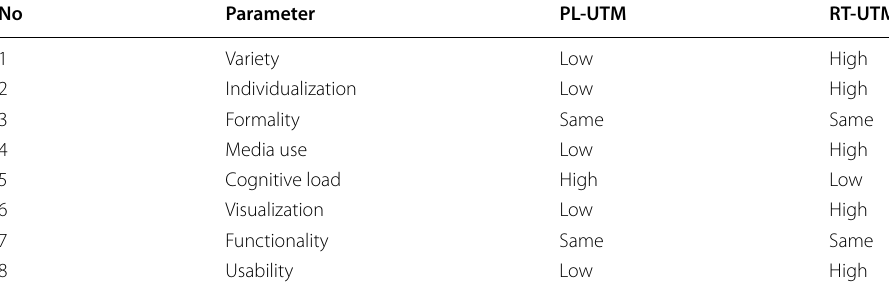
Table 1 Structure in remote triggered-UTM and physical